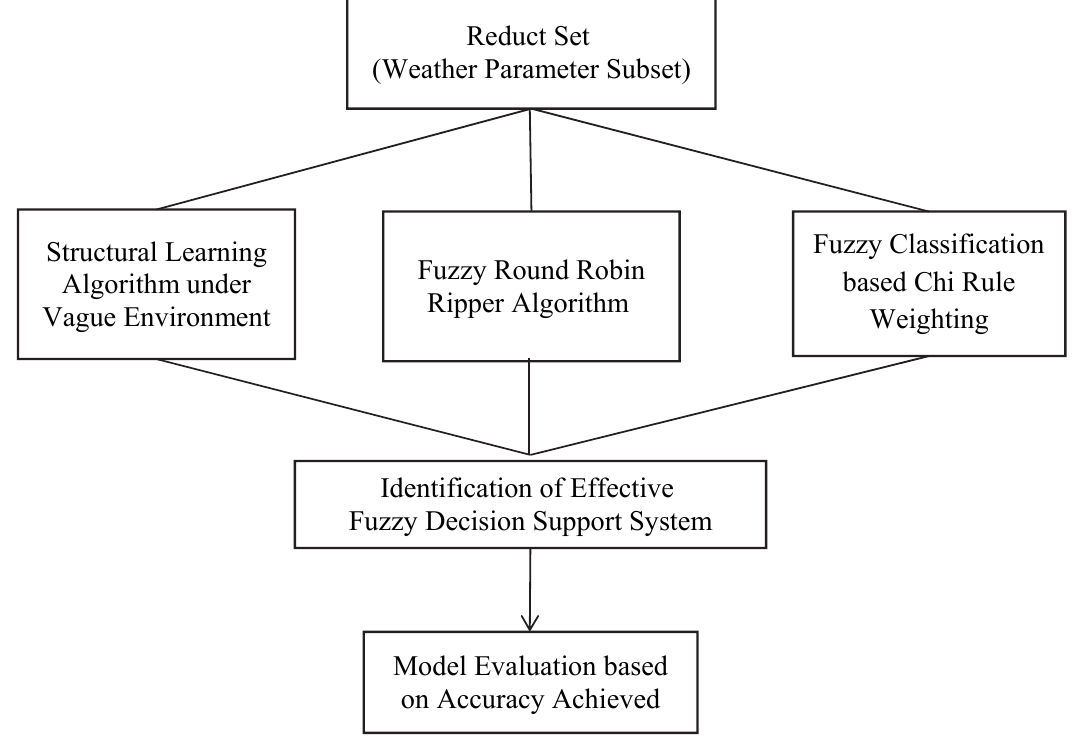
Fig. 3. Fuzzy Rule based Classification